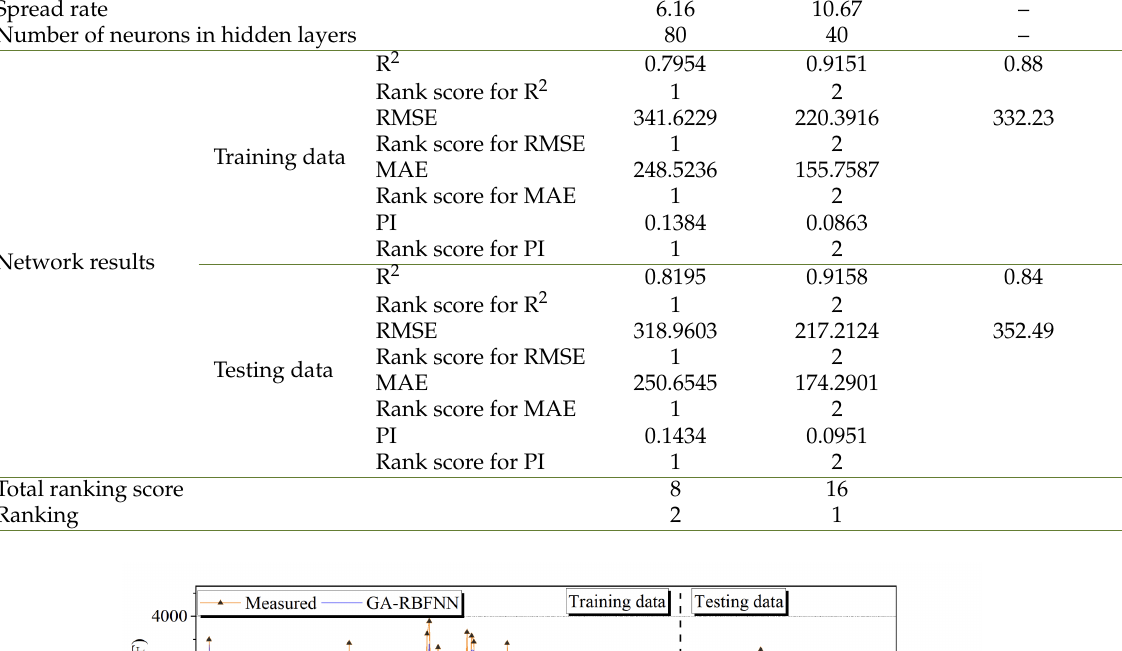
Table 2. The results of created GWO-RBFNN and GA-RBFNN models for predicting USS Models